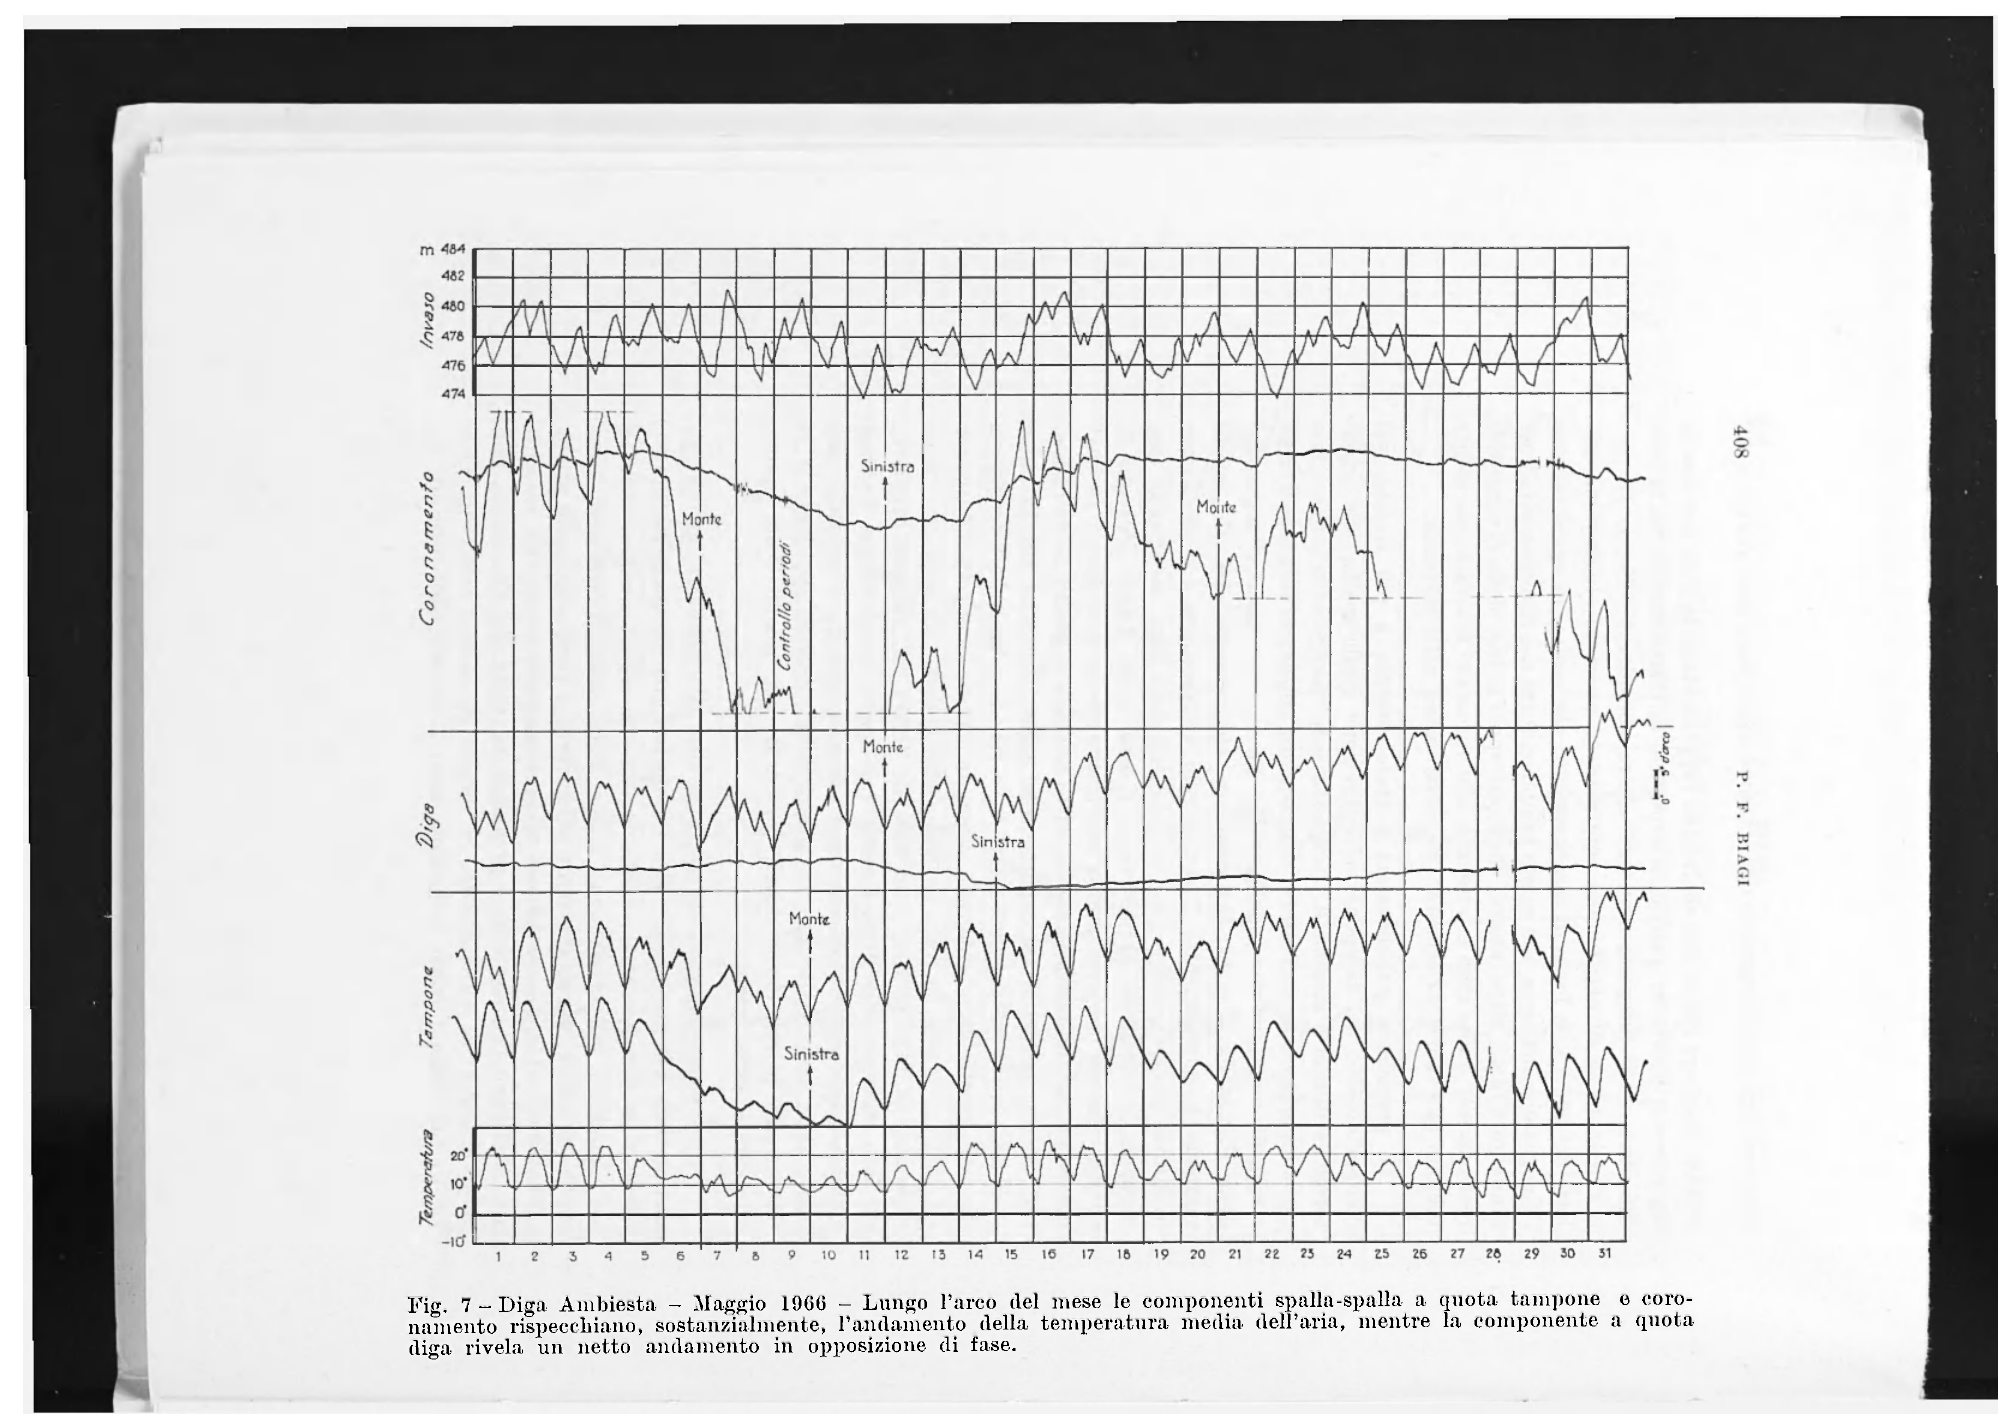
Fig. 7 - Diga Ambiesta - Maggio 1960 - Lungo l'arco del mese le componenti spalla-spalla a quota tampone e coro- namento rispecchiano, sostanzialmente, l'andamento della temperatura media dell'aria, mentre la componente a quota diga rivela un netto andamento in opposizione di